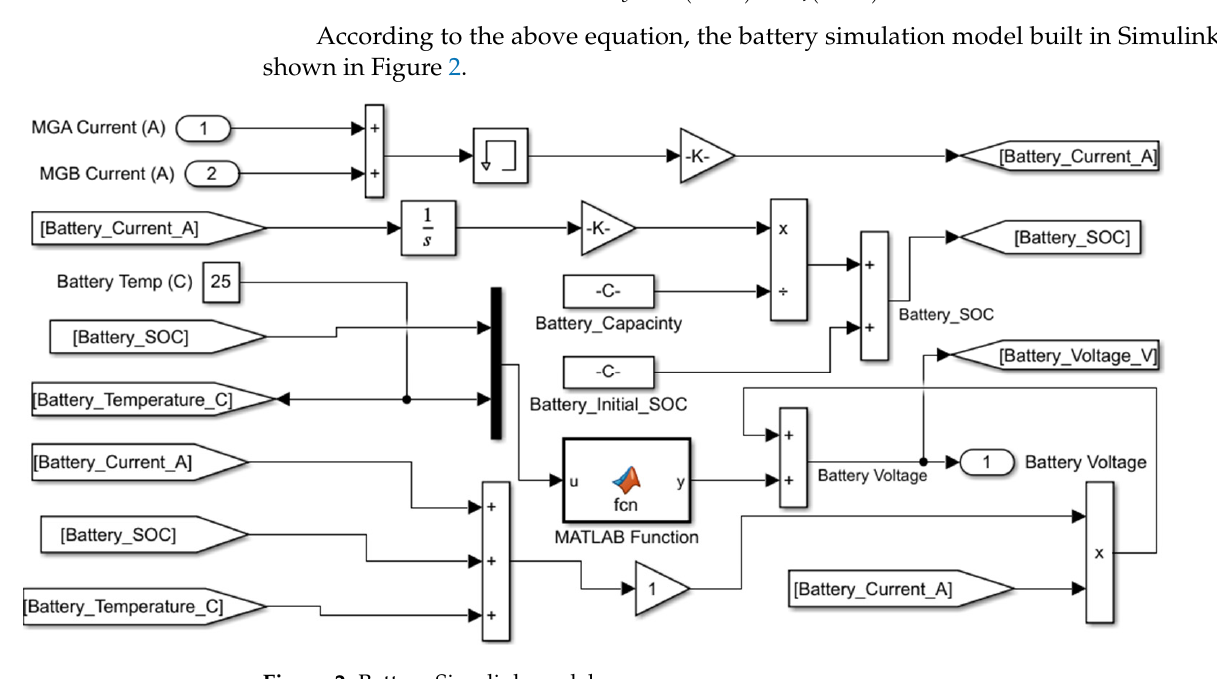
Figure 2. Battery Simulink model.